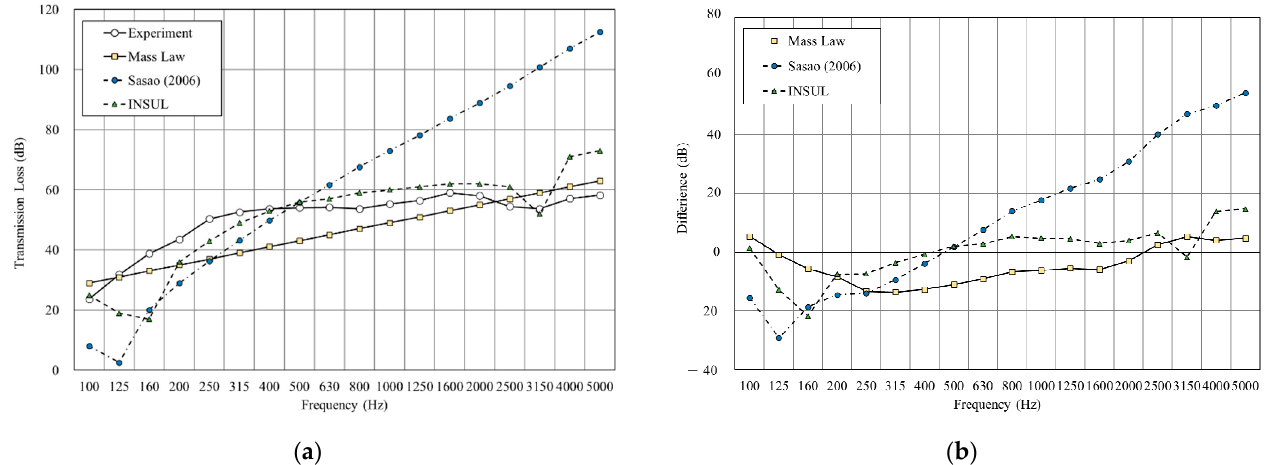
Figure 18. Comparison between experimental and predicted results of CLT + GB with 25 mm glass wool (C2). ( a ) The sound insulation performance of experiment and prediction. ( b ) The RMSE results of different prediction models.